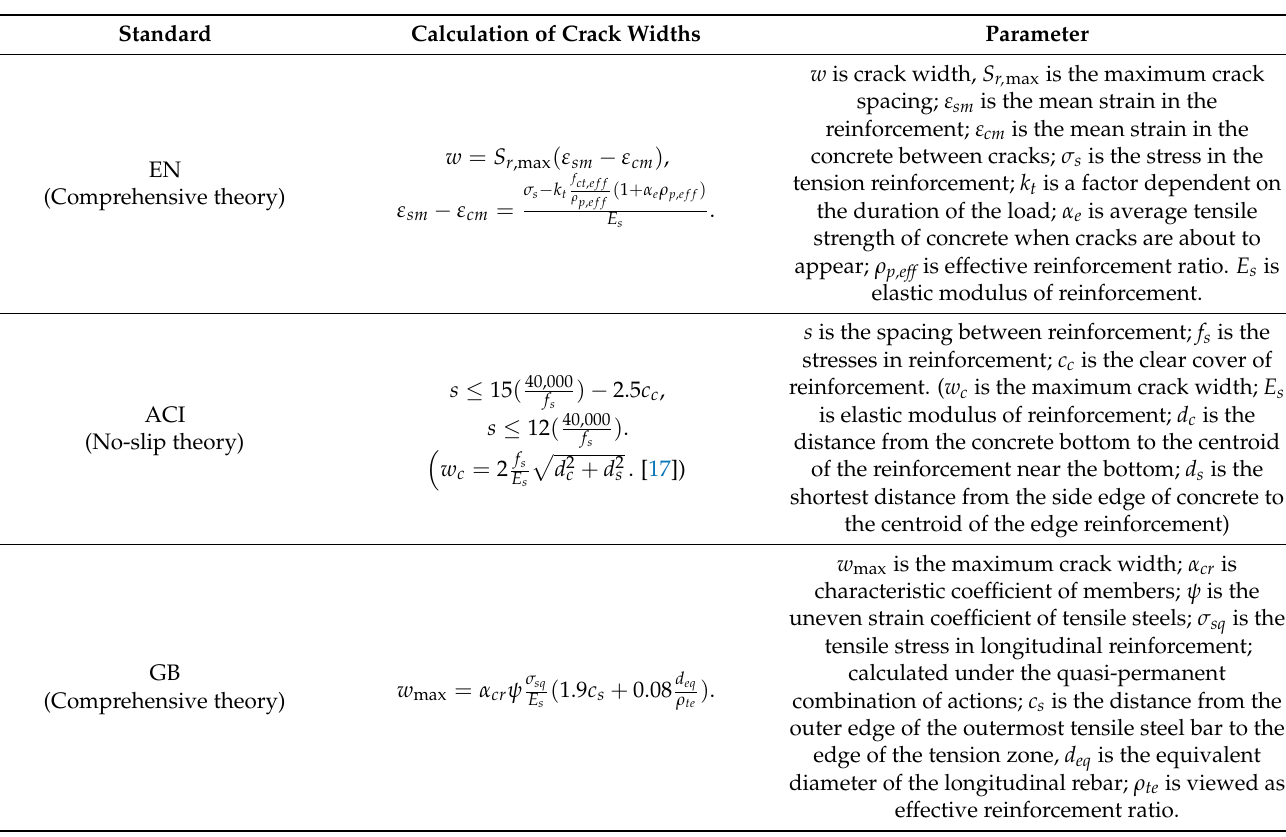
Table 1. Calculations for crack width.